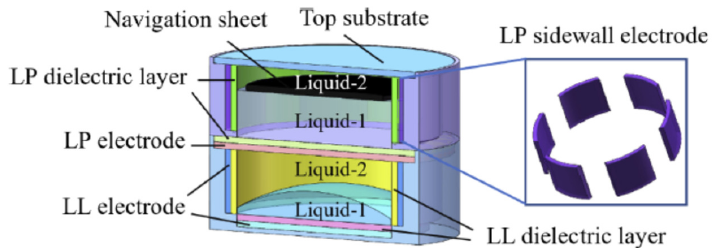
Figure 23. Multifunctional lens with single- and multi-electrode controls [127]. Reprinted with permission from Ref. [127]. 2020 The Optical Society.